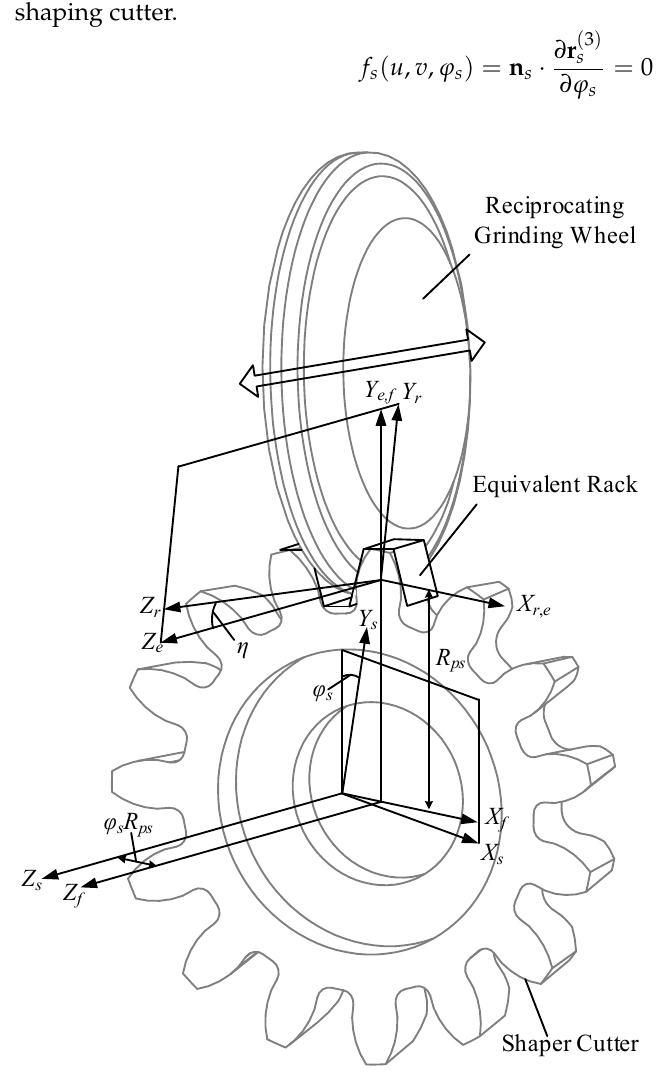
Figure 3. Coordinate systems for generating a spur shaping cutter.